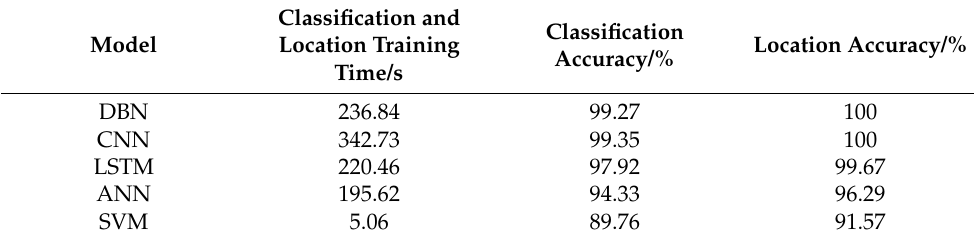
Table 5. Comparison of results from different